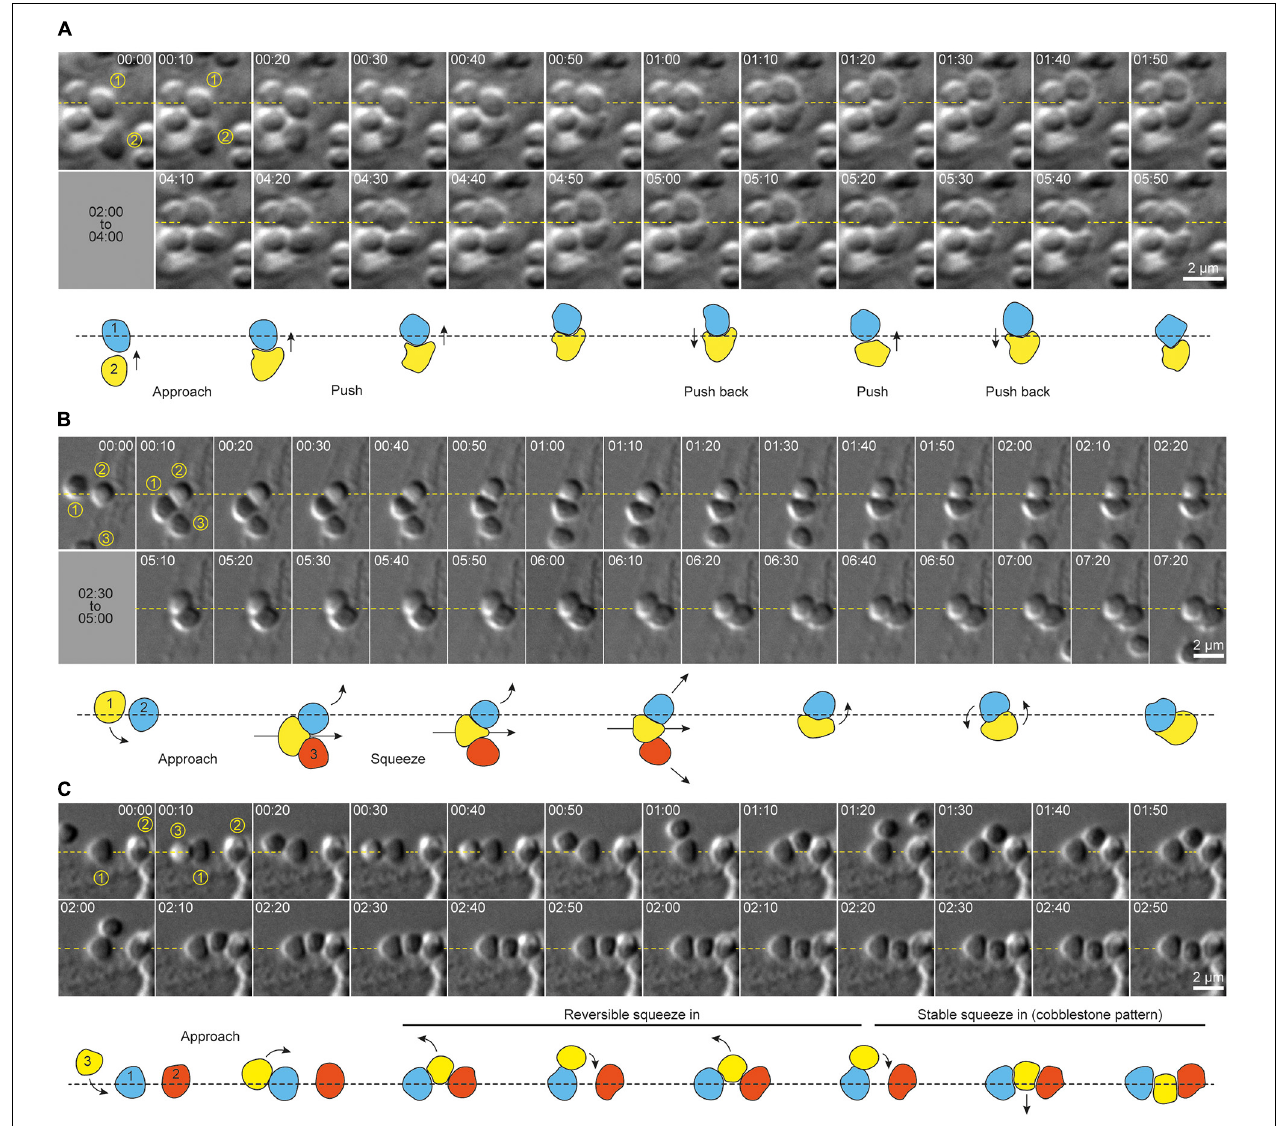
FIGURE 3 | Cell shape transitions underlie dynamic cell-cell interactions and social behavior in S. acidocaldarius . (A) Example of shape shifting in two cells interacting together. Shape transitions seem to accompany the production of force by each cell against the other. (B) Example of shape shifting in a cell (1) actively moving in between two other cells (2 and 3). Here again, shape shifting seems to occur along with the production of forces that push cells 2 and 3 aside. (C) Example of shape shifting in a cell (3) intercalating in between two pre-existing neighbor cells (1 and 2). Here, shape shifting seems reversible, as the cell 3 slides in and out of the gap between cells 1 and 2. Eventually cell 3 changes shape again to accommodate this space more stably, and form a cobblestone-like chain of cells with cells 1 and 2. DIC, 75 ◦ C, 100X + 1.5X lens. Interpretative diagrams are shown below each series of snapshots. Arrows show the direction of cell movements. Times are provided in